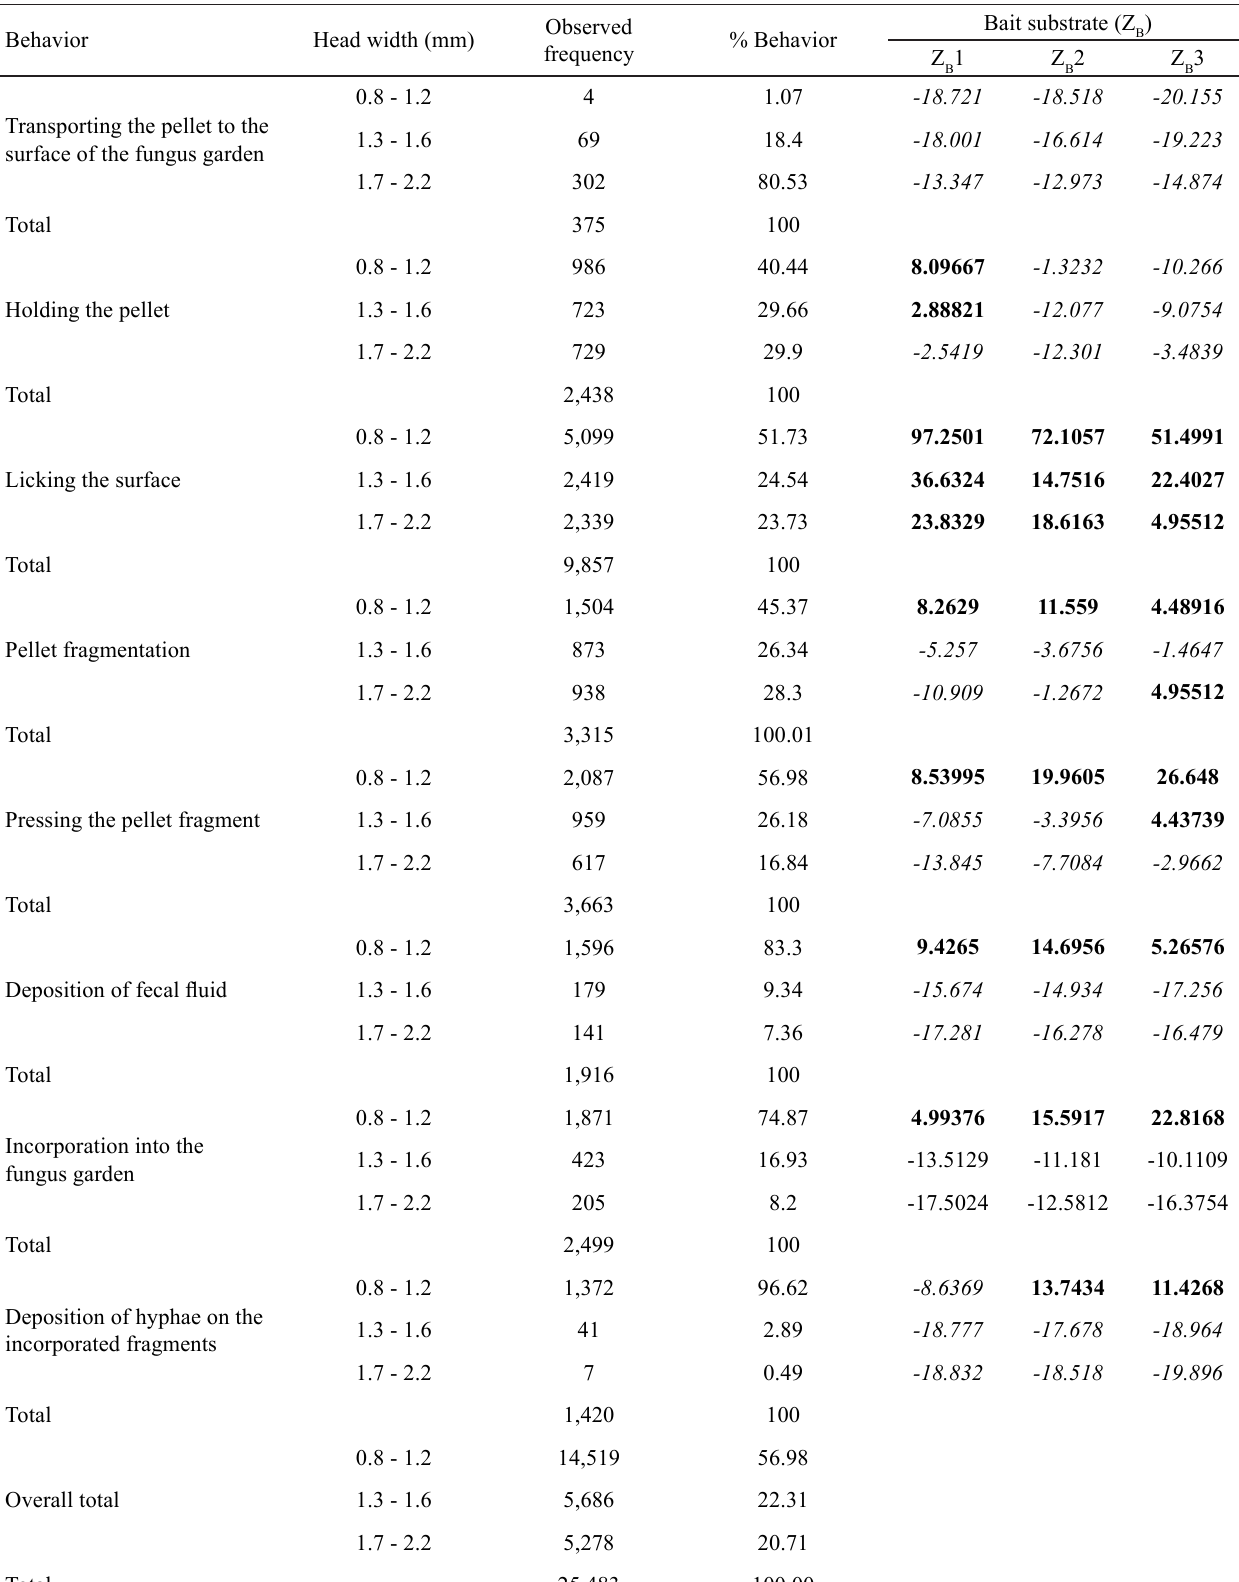
Table 2 .Standardized residuals in contingency table analysis of the behaviors executed by Atta sexdens rubropilosa during the preparation and incorporation of bait pellets as